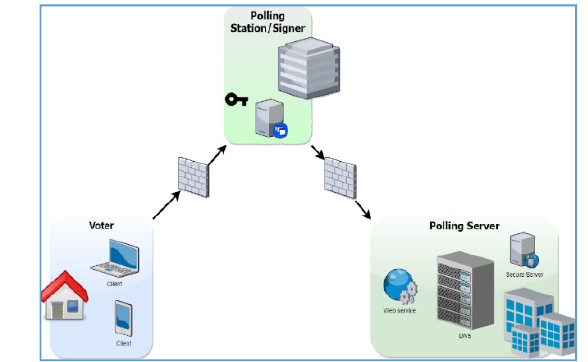
Fig. 2: Proposed Electronic Voting